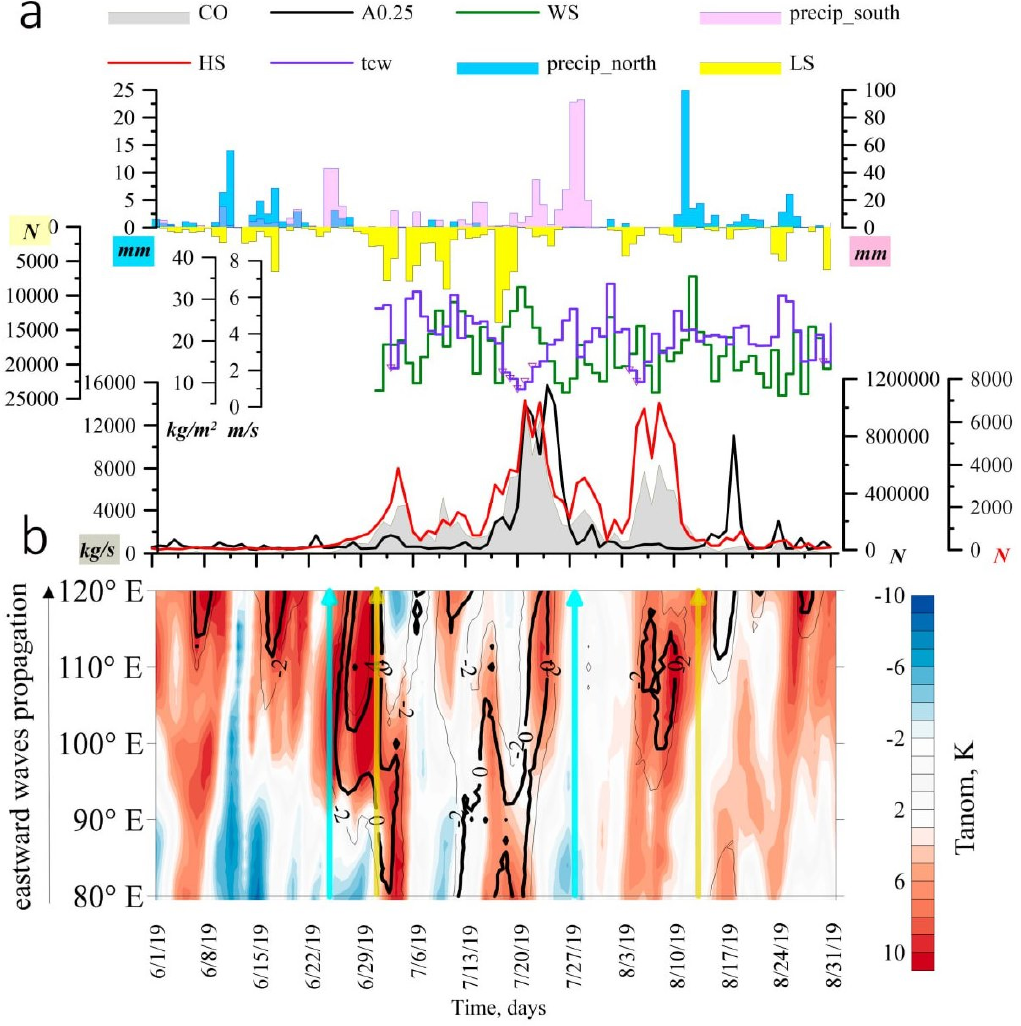
Figure 1. ( a ) Total CO emission (90 ◦ E–120 ◦ E, 55 ◦ N–65 ◦ N) (kg/s), A0.25 aerosol concertation in Western Siberia (Fonovaya) (N), HS—the total number of hotspots (90 ◦ E–120 ◦ E, 55 ◦ N–65 ◦ N); the total number of the lightning strikes (LS); WS—surface wind speed; tcw—total column water; precip— atmospheric precipitation. tcw, ws, precip_north for the center of forest fire area 105 ◦ E–60 ◦ N, precip south: for June 54.5 ◦ N–97.5 ◦ E, for July the average amount for two grid points: 51.5 ◦ N, 103.5 ◦ E and 104.5 ◦ E; ( b ) Time-longitude cross-sections of GHGS (m/ ◦ lat). GHGS > 0 corresponds blocking, GHGS > − 2—near blocking, Era-Interim data, red and blue fill—surface temperatures anomalies. Light blue vertical line—high precipitation events; yellow vertical line—start and finish of forest fire